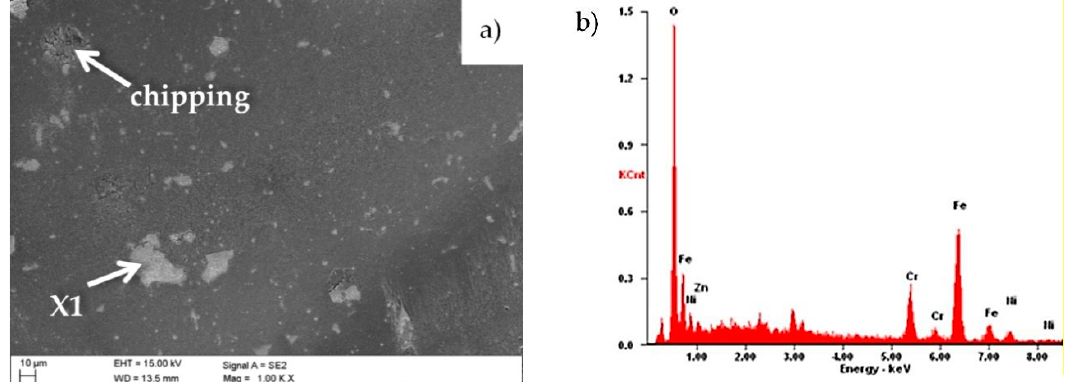
Figure 16. ( a ) Wear place after the “ball-on-plate” wear test for the Al 2 O 3 ball as a counter-sample, ( b ) X-ray energy dispersive plot of the area X1 shown in Figure 16a.